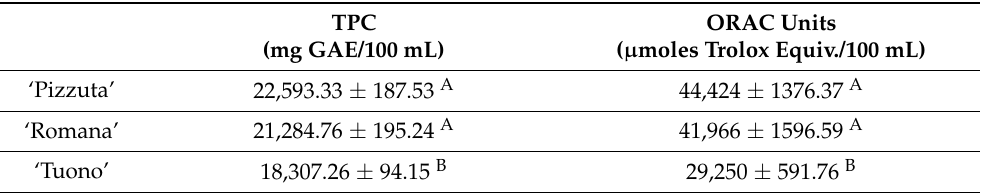
Table 3. Total Phenolic Content (TPC) and Oxygen Radical Absorbance Capacity (ORAC) units in ‘Pizzuta’, ‘Romana’ and ‘Tuono’ hull extracts. TPC ORAC Units (mg GAE/100 mL) ( µ moles Trolox Equiv./100 mL) ‘Pizzuta’ 22,593.33 ± 187.53 A 44,424 ± 1376.37 A ‘Romana’ 21,284.76 ± 195.24 A ‘Tuono’ 18,307.26 ± 94.15